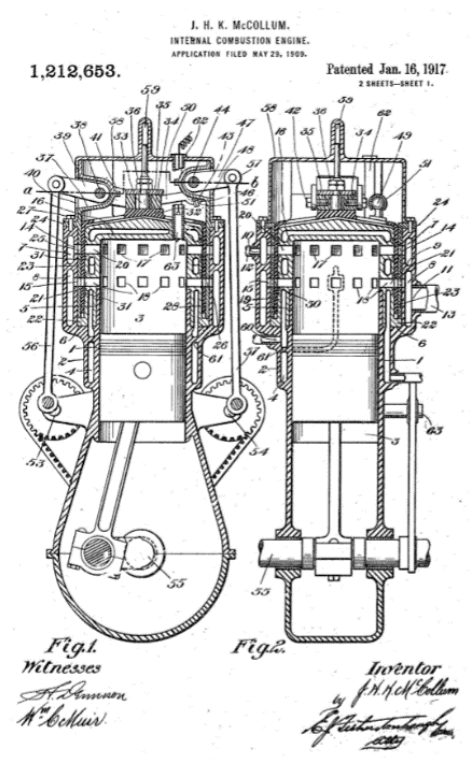
Figure 3. James McCollum, 29 May 1909, internal combustion engine, Patent US 1212653. Repro-